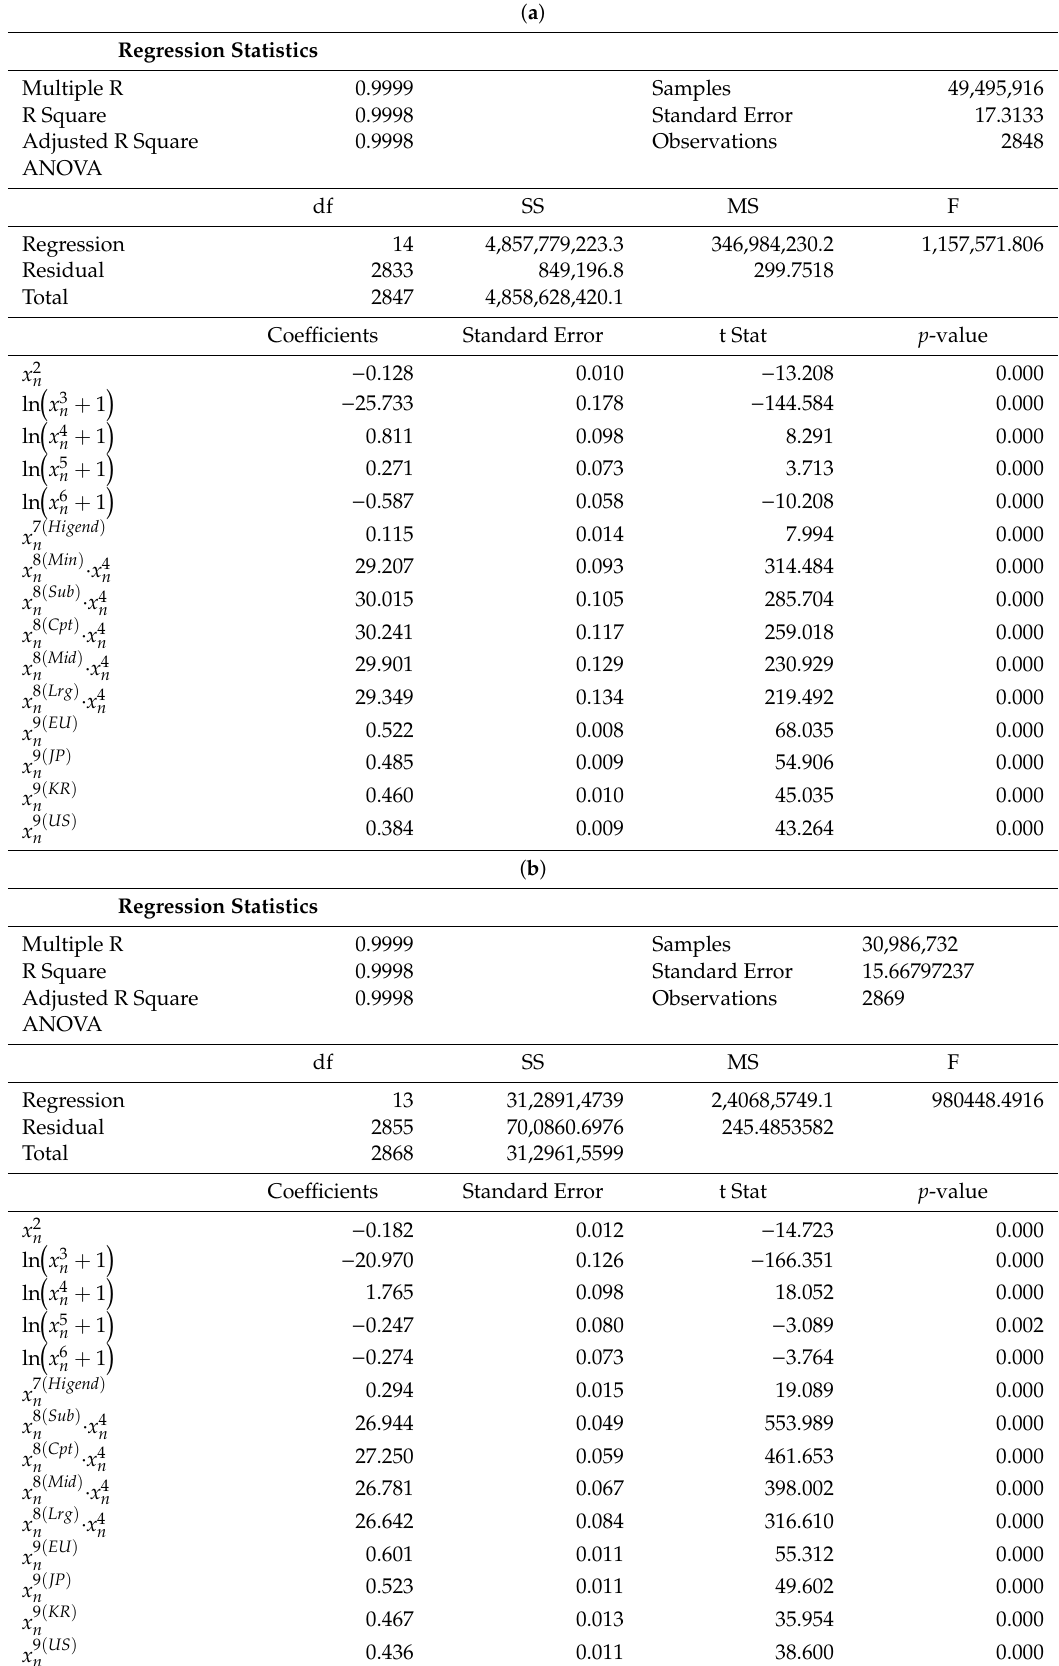
Table 7. ( a ) Statistical results. ( b ) SUV / crossover